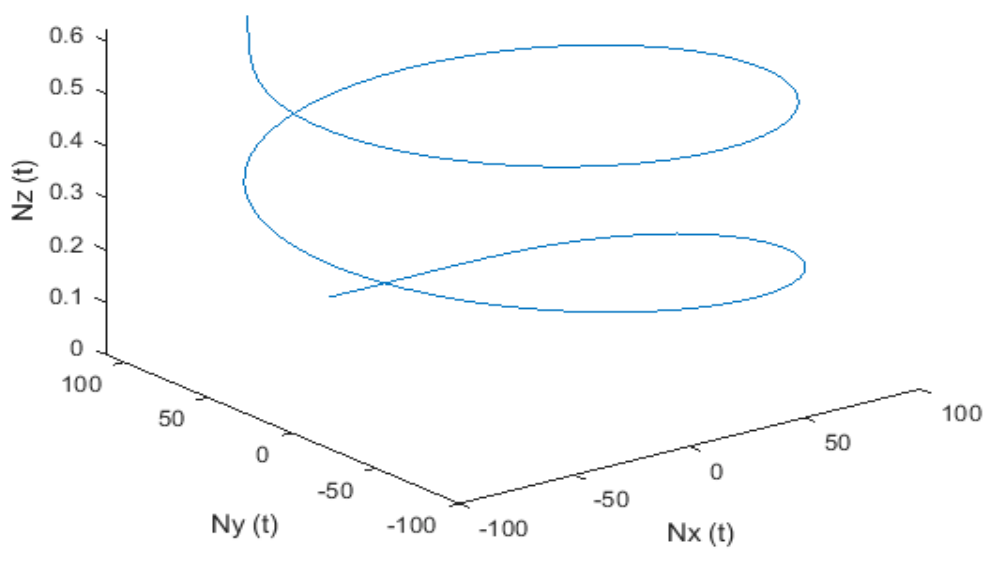
Figure 13. Numerical solutions of the Bloch equation with parameters: α = 1, β = 1, γ = 0.9, w 0 = 12, T 1 = 1, T 2 = 20, a = 1, b = 1.